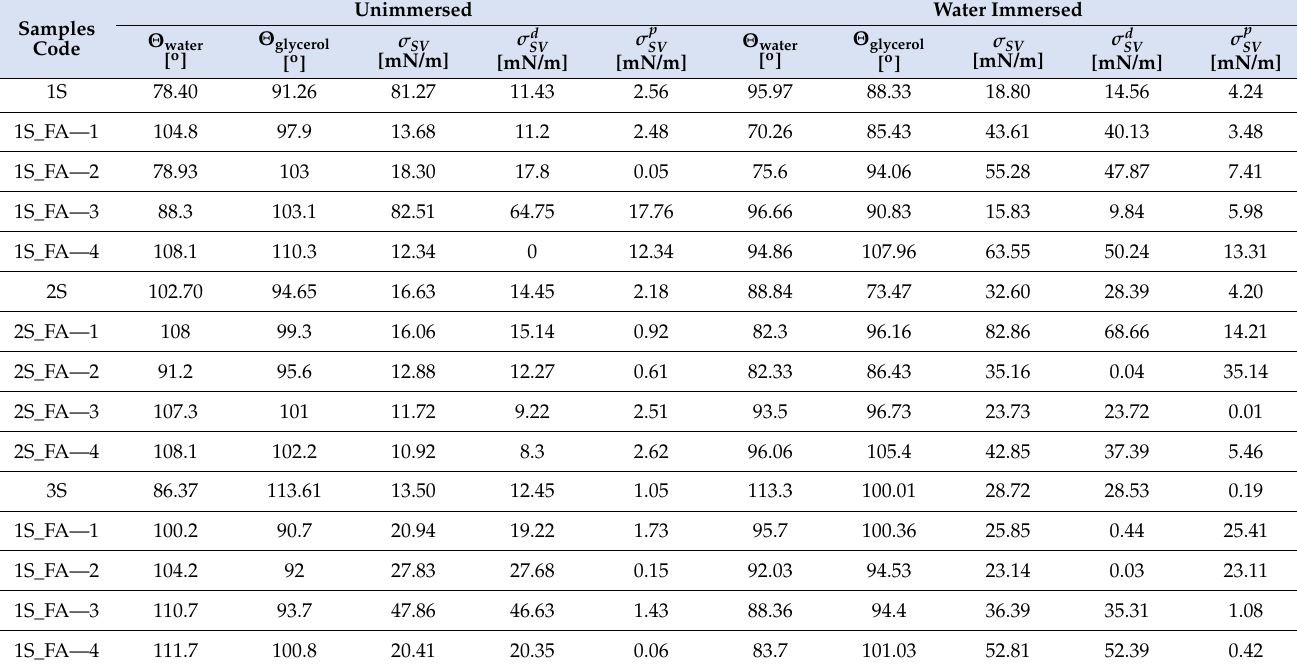
Table 3. Surface energies with dispersive and polar components for composites with fly ash unim- mersed and water